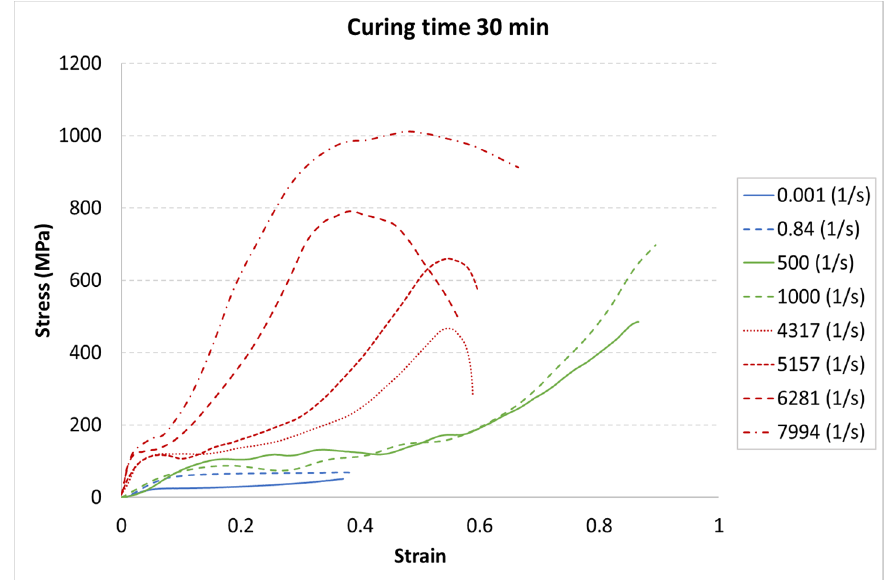
Figure 7. Results of durable resin tested under various strain rates for a curing time of 30 min for UV and heat exposure.